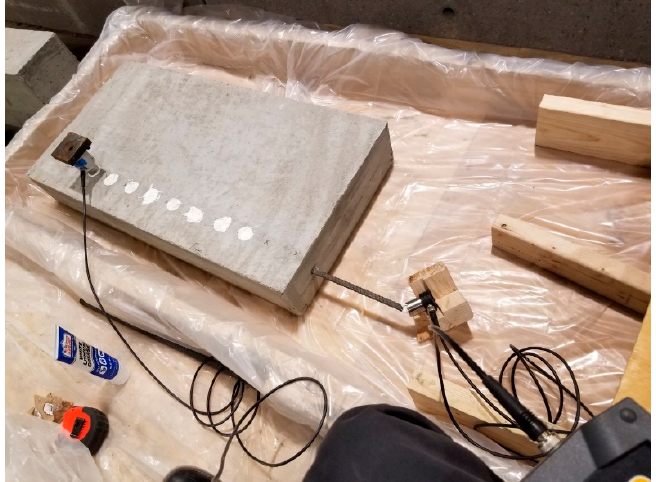
Figure 7. One of the Specimen Set 3 slabs, showing sensor locations.